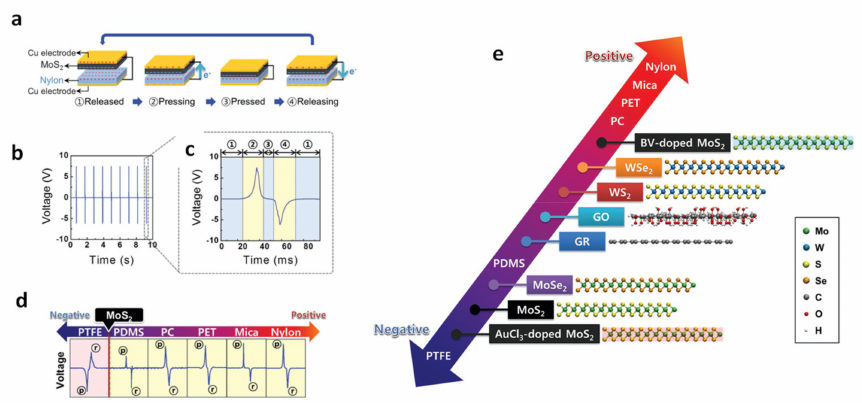
Figure 11. Triboelectric behavior of MoS 2 and several polymer films: ( a ) the device structure and working principle of MoS 2 -nylon TENG, ( b ) the output voltage signal, and ( c ) its output voltage signal in one cycle. ( d ) Triboelectric behavior of various polymer film-MoS 2 combinations. ( e ) The modified triboelectric series with 2D materials. Reproduced with permission from [75]. Copyright 2018, John Wiley and